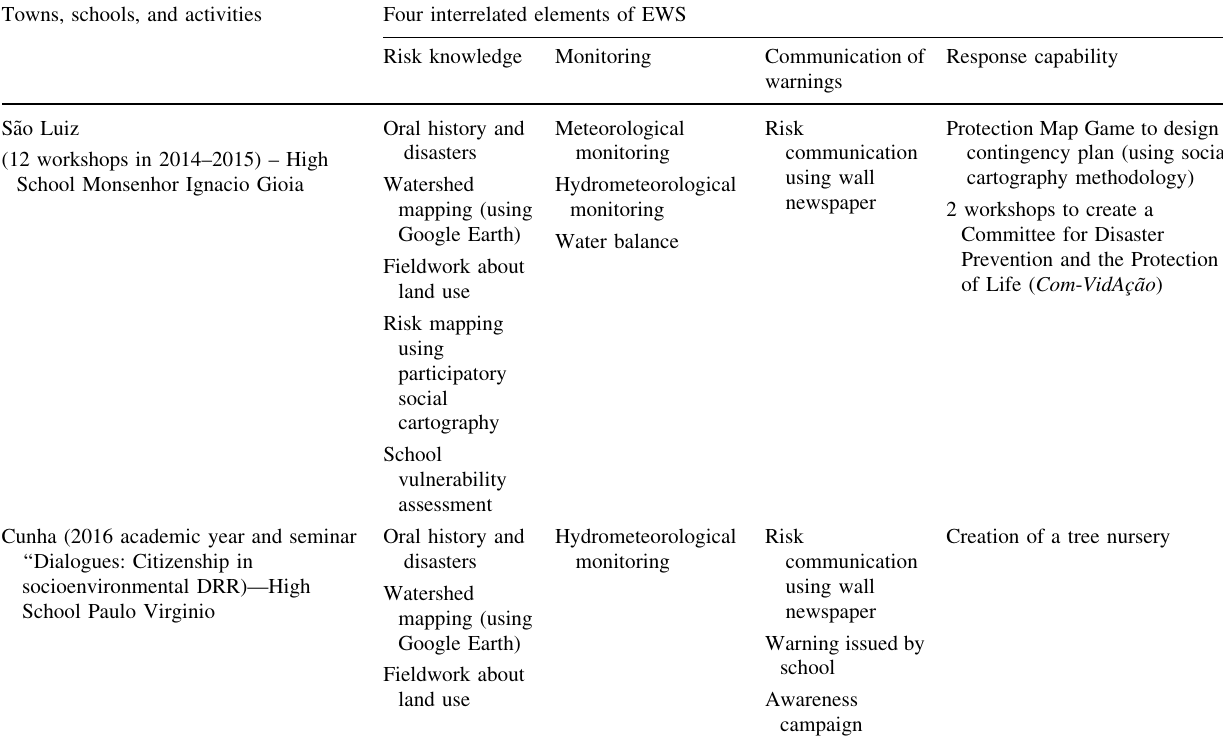
Table 1 Four interrelated elements of EWS and hands-on participatory learning interdisciplinary activities led by high schools Towns, schools, and